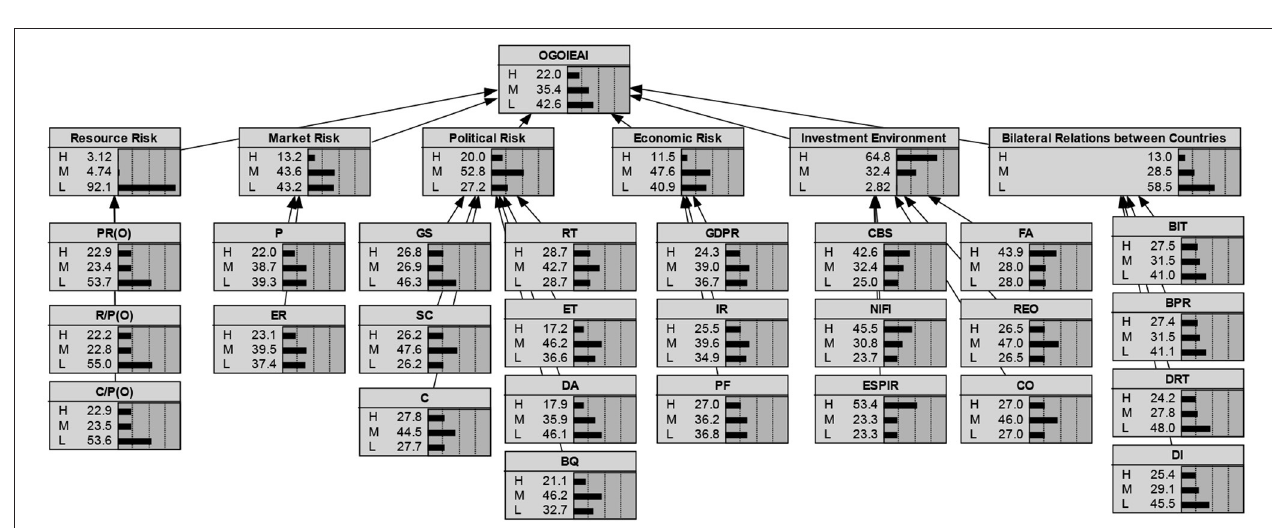
FIGURE 4 | Oil and gas investment risk assessment of Brazil in